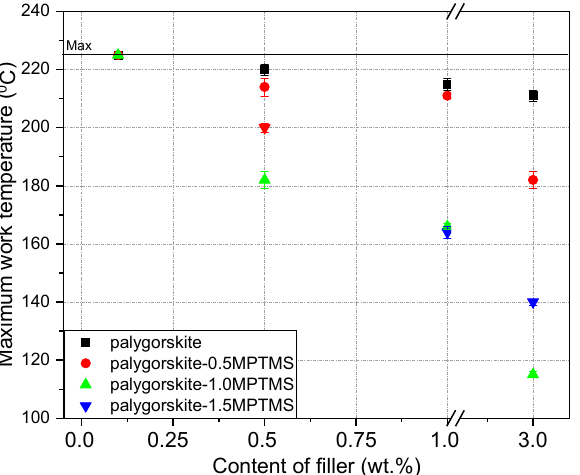
Figure 12. Influence of palygorskite modified by MPTMS addition on Si-PSA tape SAFT.